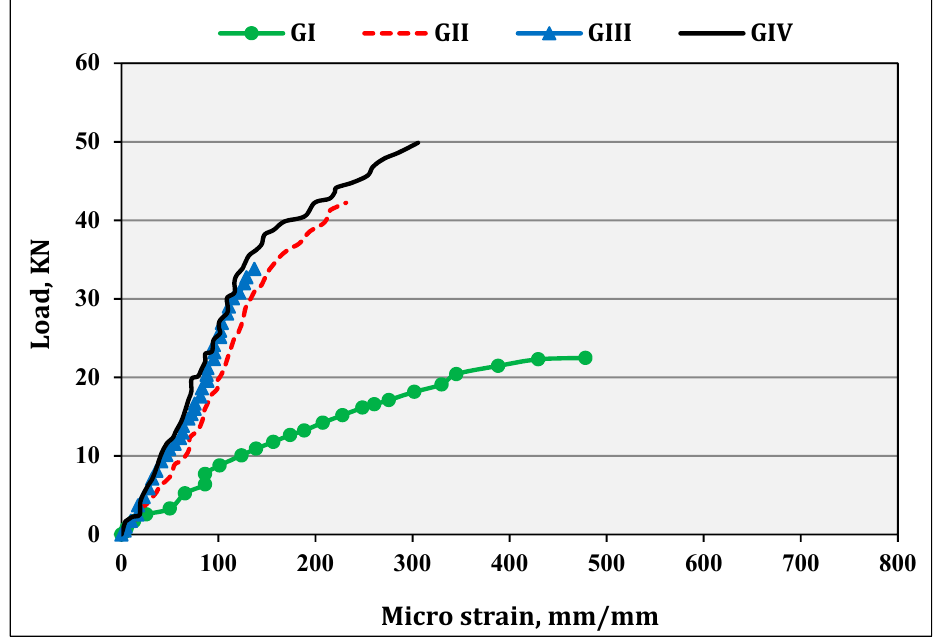
Figure 13. Load vs. tensile strain in EBR-CFRP laminates at end-span for an average of tested groups.